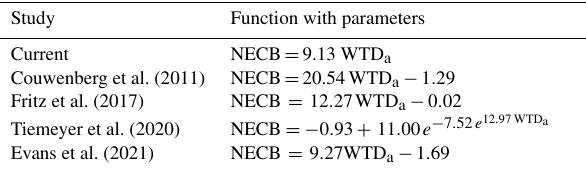
Table 4. Overview of available fitted empirical relations to esti- mate NECB based on mean annual water table depth below surface (WTD a ) plotted in Fig.